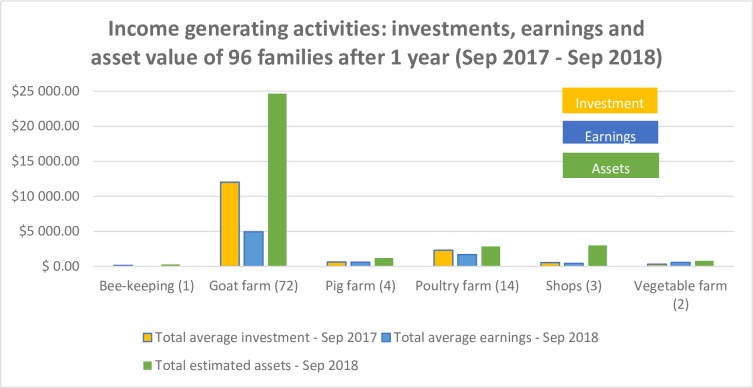
Income generating activities: Investments, earnings and value assets over 1 year.